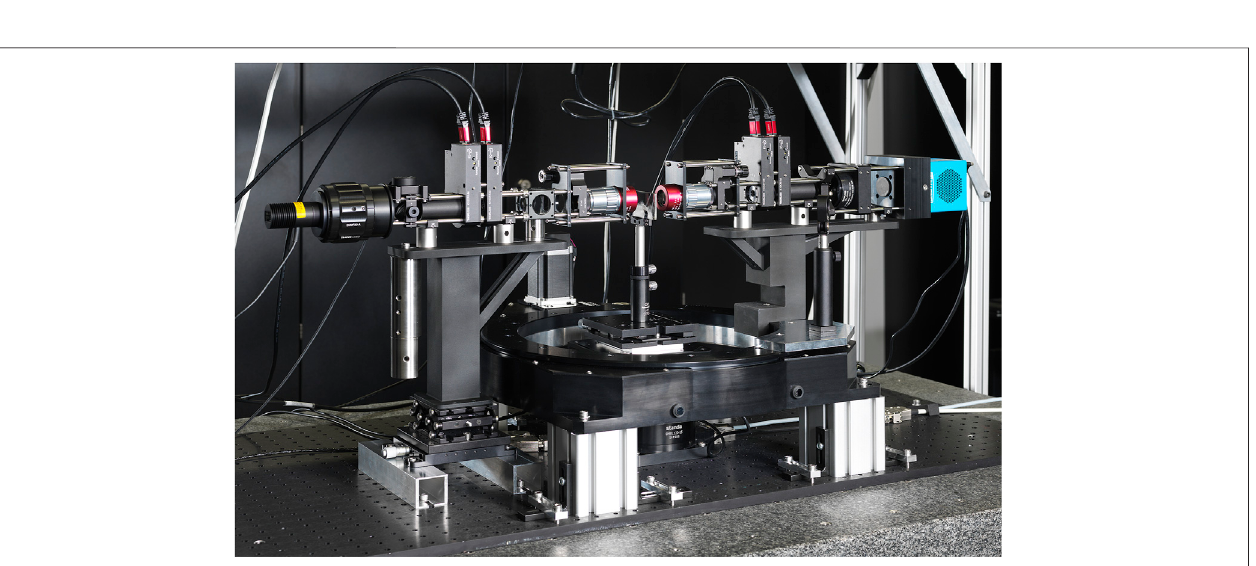
FIGURE 2 | Imaging Mueller matrix ellipsometry